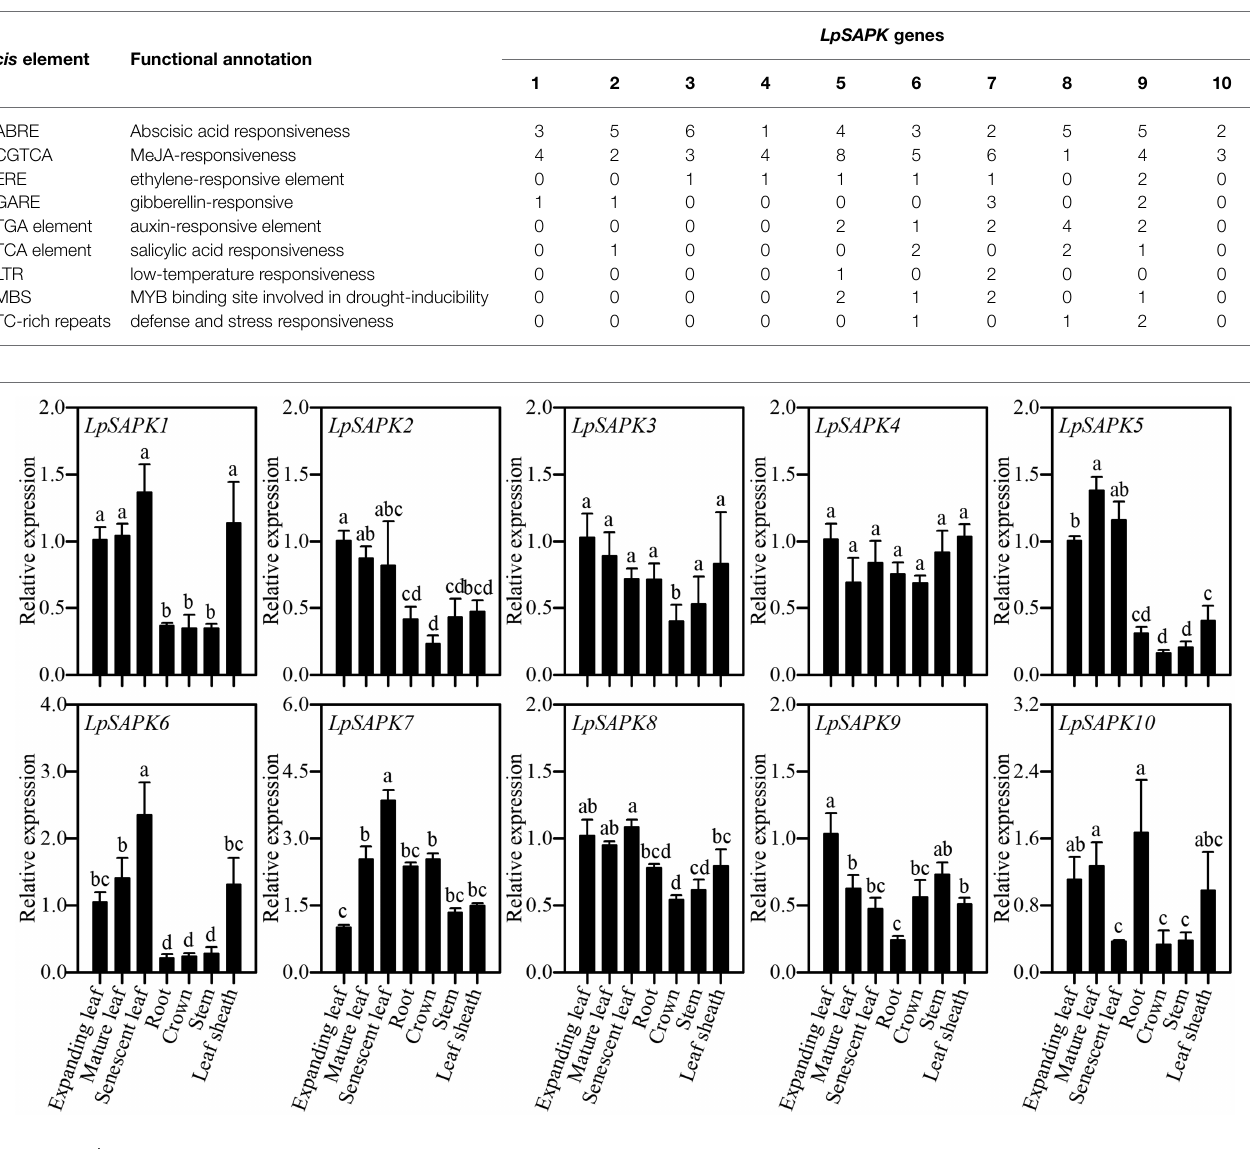
FIGURE 5 | Relative expression levels of LpSAPKs in different organs. Data are means ± SE ( n = 4). Different letters above bars represent significant differences at p ≤